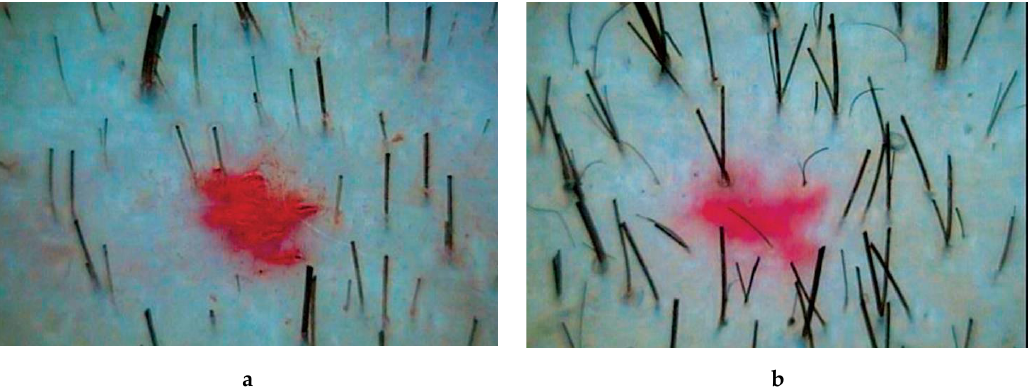
Figure 2. Trichoscopy (phototrichography) of a patient who received complex therapy-applications of a 5% minoxidil solution and PRP injections: a —before treatment; b —after treatment. Magnification × 60.